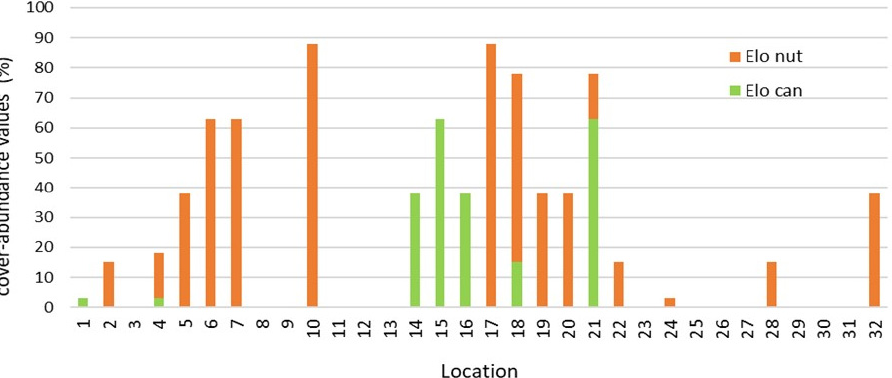
Figure 3. Relative abundance of invasive alien species Elodea canadensis and E. nuttallii in surveyed waterbodies.